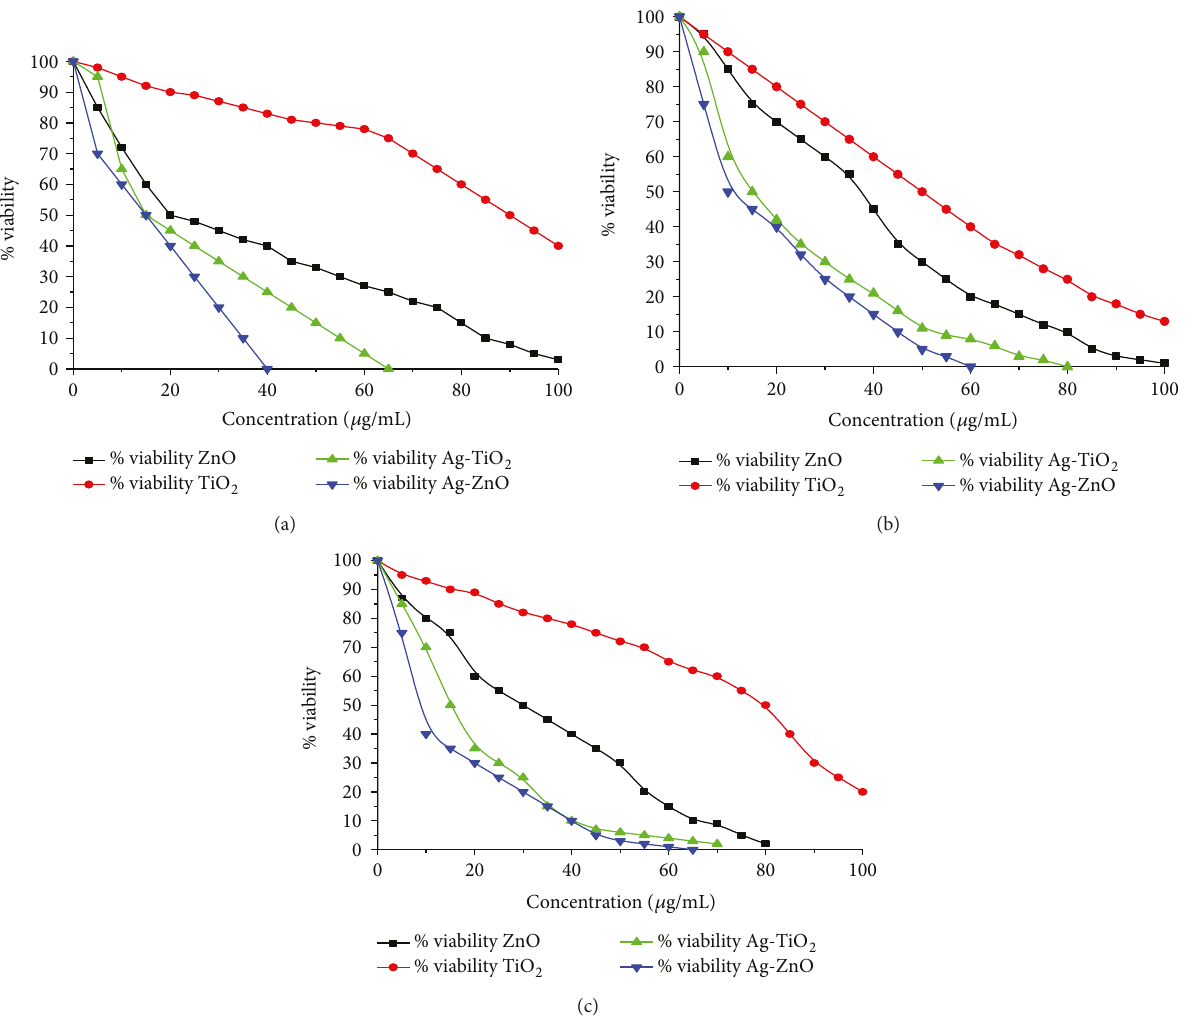
Figure 5: Viability of (a) P. aeruginosa , (b) S. aureus , and (c) E. coli with respect to the concentration of NPs in μ g/mL.